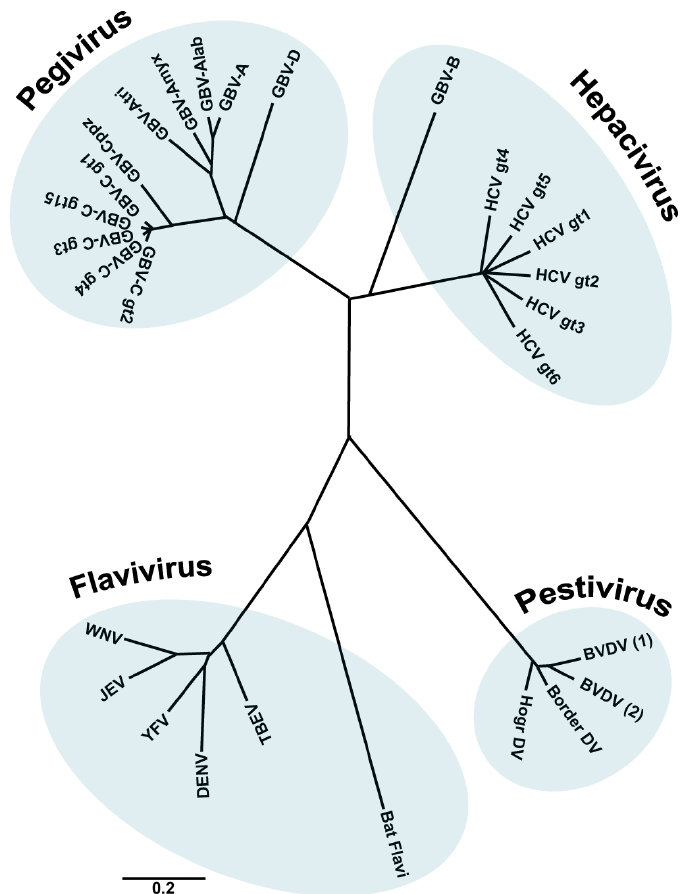
Figure 1. The family Flaviviridae . Phylogenetic tree based on the analysis (neighbour joining) of aligned conserved motifs of the RNA dependent RNA polymerase (RdRp). Shown are selected members of the family. A distance scale corresponding to amino acid substitutions per position is shown. (Figure adapted from [1], with